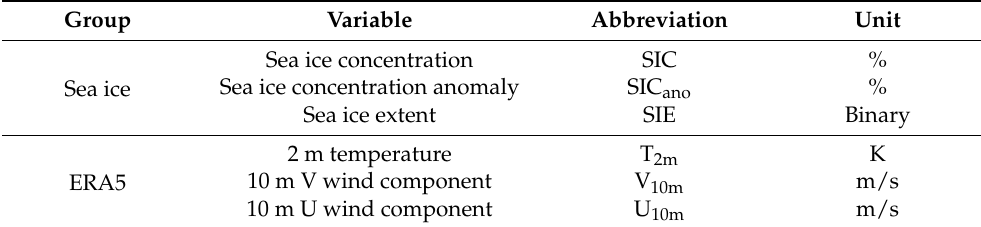
Table 1. Details of input variables used in the Arctic sea ice prediction